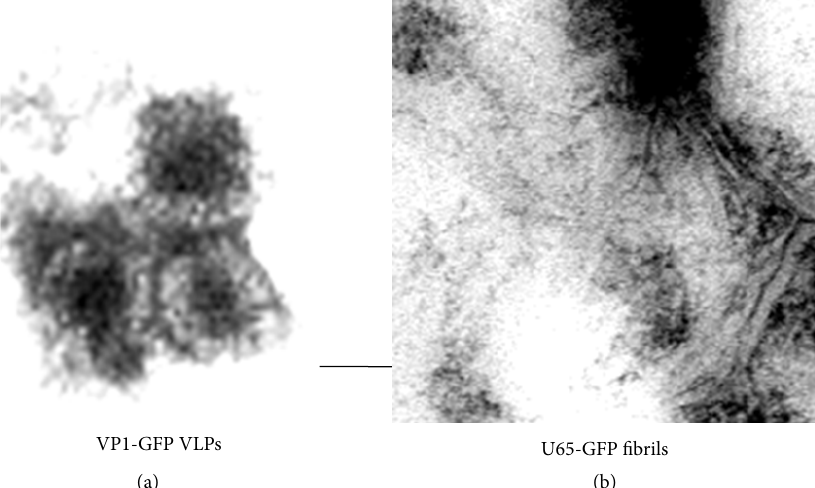
Figure 7: Negative-stain electron microscopy of (a) VP1-GFP VLPs and (b) aggregated fibrils of U65-GFP. The bar indicates 50 nm.